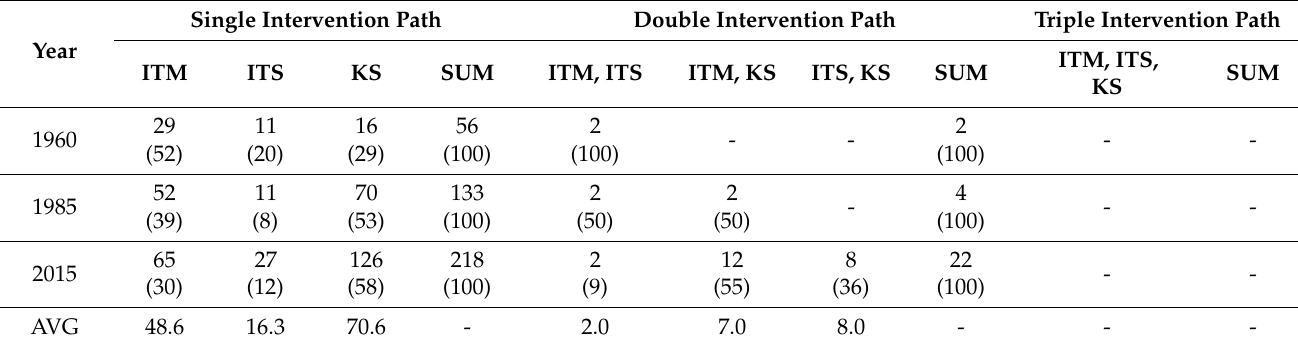
Table 4. Changes in smart intervention paths (unit: